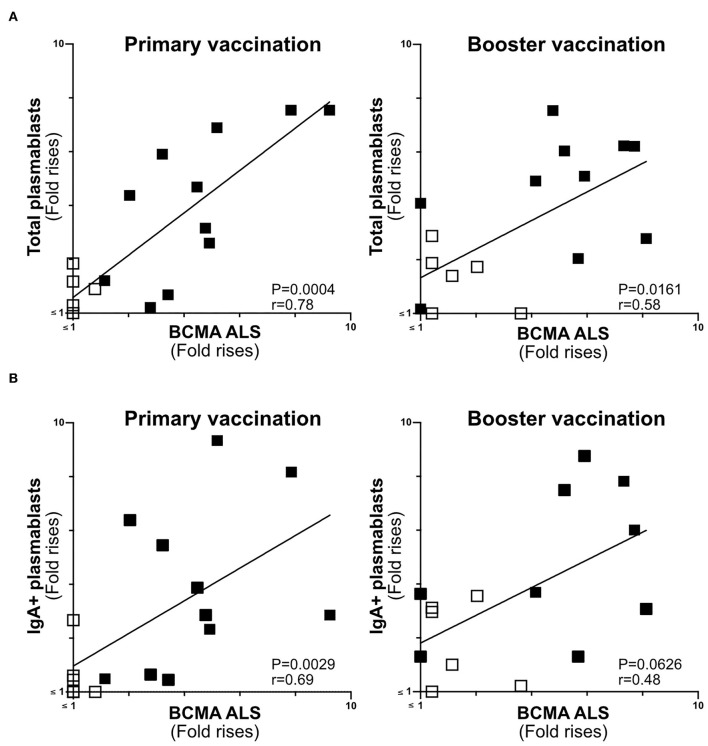
ALS BCMA response magnitudes correlate with ETVAX induced plasmablast responses. (A) Correlations of the magnitudes of total plamablast responses (fold rises in frequencies of CD19+CD27+CD38high cells among cells detected by flow cytometric analysis in post compared to pre-vaccination samples) induced by primary and booster ETVAX vaccination with ALS BCMA responses (n = 17). (B) Correlations of the magnitudes of IgA+ plamablast responses induced by primary and booster ETVAX vaccination with ALS BCMA responses (n = 16). Each symbol represents one individual. Filled squares represent vaccine responders with an ALS IgA combined response index >150. Open squares represent vaccine responders with an ALS IgA combined response index <135.